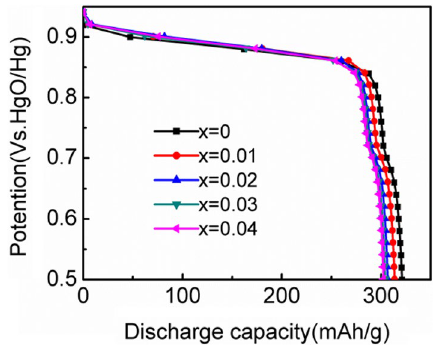
Fig. 9 Discharge voltage curves of the Re ( x = 0 ‒ 0.04)